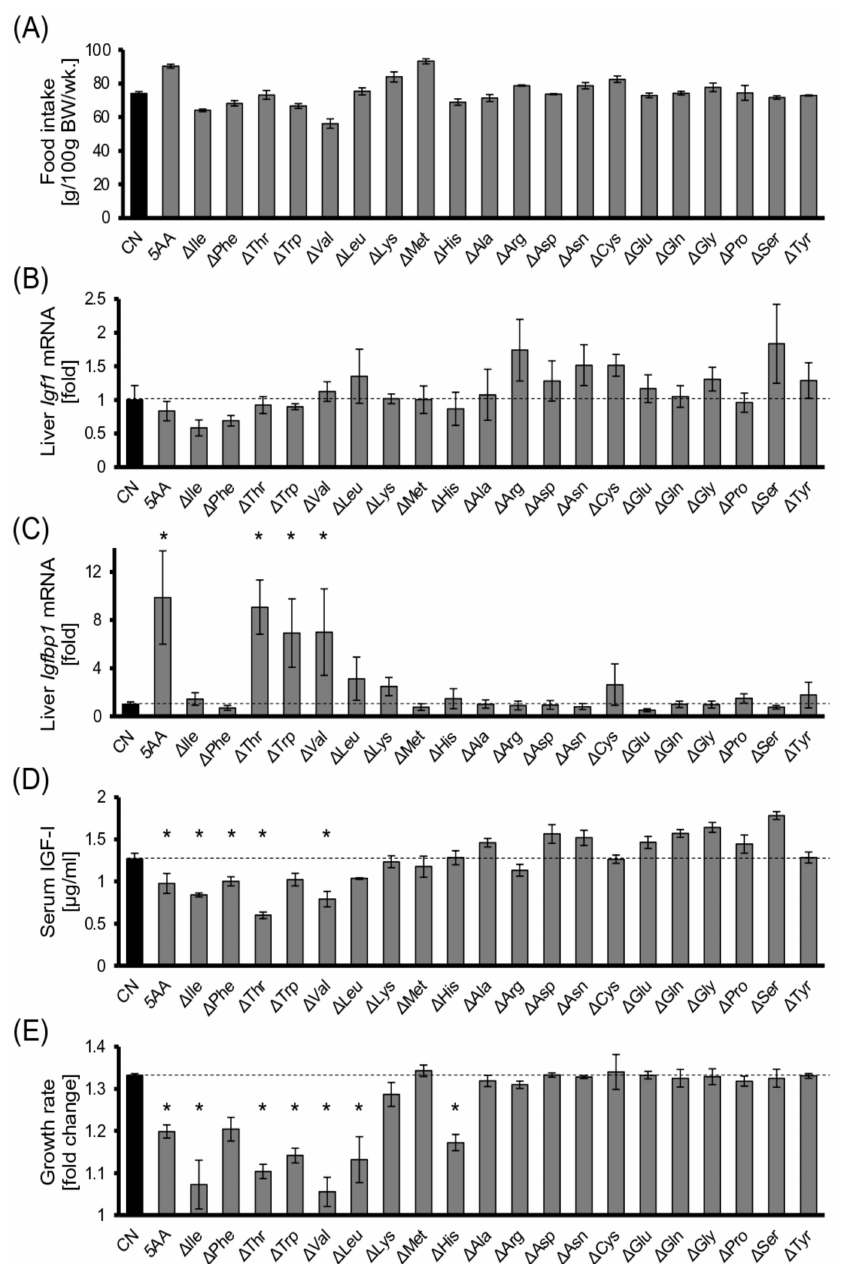
Figure 1. Essential amino acid intake is required to sustain serum IGF–I levels. Six-week-old male Wistar rats were reared on the control diet containing a 15% amino acid mixture as the sole nitrogen source (CN), a low–amino acid diet containing 5% amino acids (5AA), and diets where only a single amino acid was reduced to the same level as that of the 5AA diet ( ∆ —) for 7 days. ( A ),Total food intake during the experiment; ( B , C ) Liver Igf1 and Igfbp1 mRNA levels were measured using real– time qPCR. The values were normalized against 18S rRNA; ( D ) Serum IGF–I levels; ( E ) The ratio of the final body weight to the initial body weight; Bar: mean ± S.E.M., * p < 0.05, Dunnett’s test (vs. CN), n =